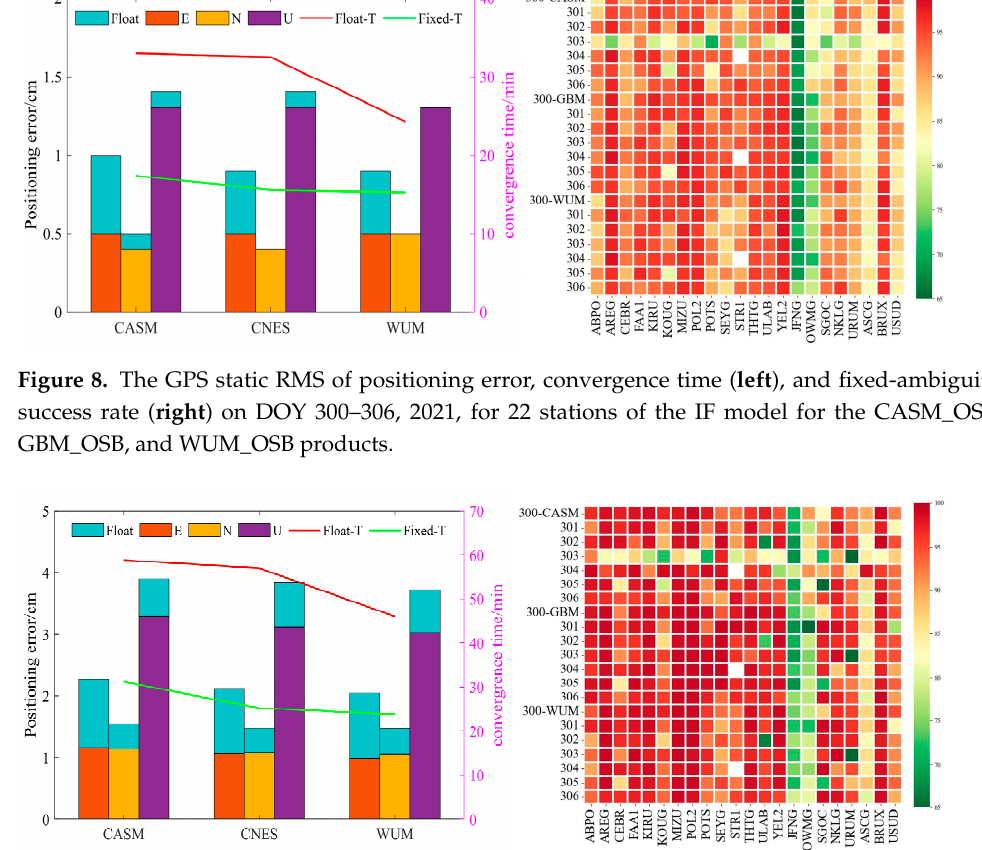
Figure 9. The GPS kinematic RMS of positioning error, convergence time ( left ) and fixed-ambiguity success rate ( right ) on DOY 300–306, 2021, for 22 stations of the IF model for the CASM_OSB, GBM_OSB, and WUM_OSB products. Table 4. The RMS results of positioning error and convergence time of the GPS-only and GCE float/fixed PPP static (left) and kinematic (right) of different institutions on DOY 300-306, 2021, for 22 stations.